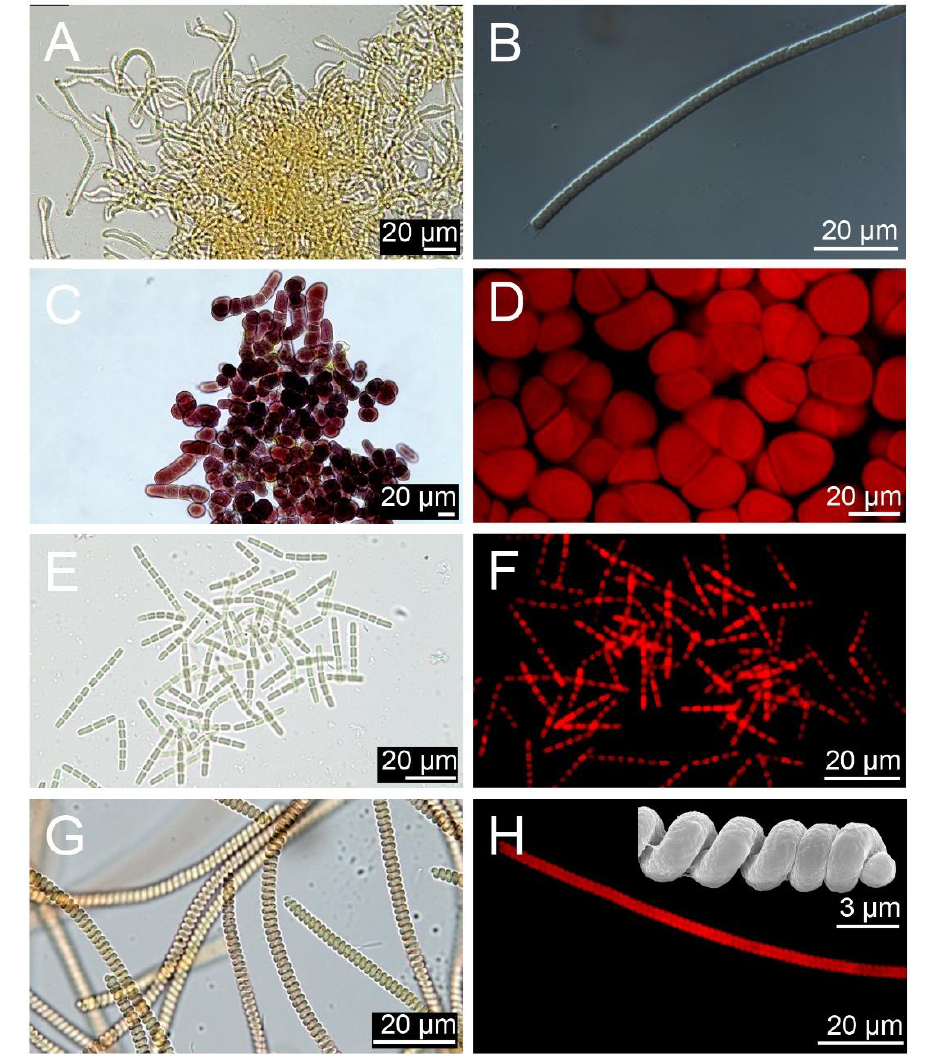
Figure 5. Light microscopy (LM), fluorescence, and scanning electron microscopy (SEM) images of cultured cyanobacterial strains. ( A ) Phormidesmis sp. TIOX96. ( B ) Phormidesmis sp. showing the chlorophyll autofluorescence and SEM of cell. ( C ) Pleurocapsa sp. TIOX102. ( D ) Pleurocapsa sp. showing the chlorophyll autofluorescence. ( E ) Pseudanabaena sp. TIOX98. ( F ) Pseudanabaena sp. showing the chlorophyll autofluorescence. ( G ) Spirulina sp. TIOX113. ( H ) Spirulina sp. showing the chlorophyll autofluorescence and SEM of a cell.